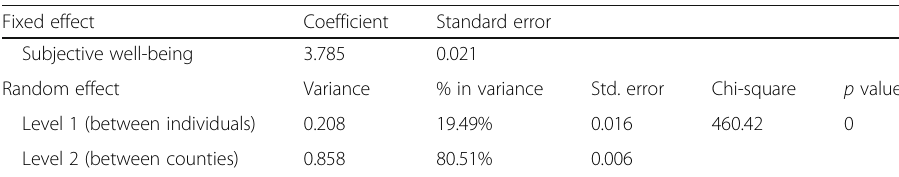
Table 2 Decomposition of variance of